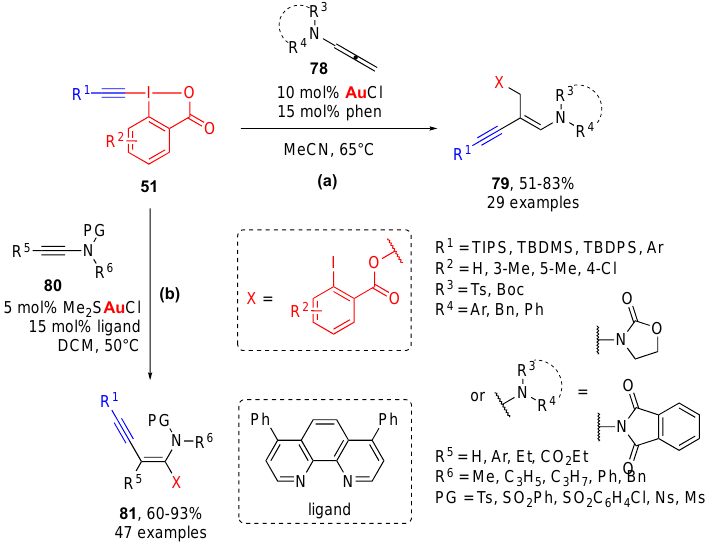
Scheme 17. Atom economical gold-catalyzed alkynylation with the use of EBXs 51 . See explanation of reactions ( a – b ) in the text. Multisubstituted alkenes 81 are also accessible by regio- and stereo-selective gold- catalyzed acyloxyalkynylation of ynamides 80 with EBXs 51 (Scheme 17b) [95]. This effi- cient transformation tolerates a diverse set of functionalities, thus providing a wide range of amide enol 2-iodobenzoates 81 .